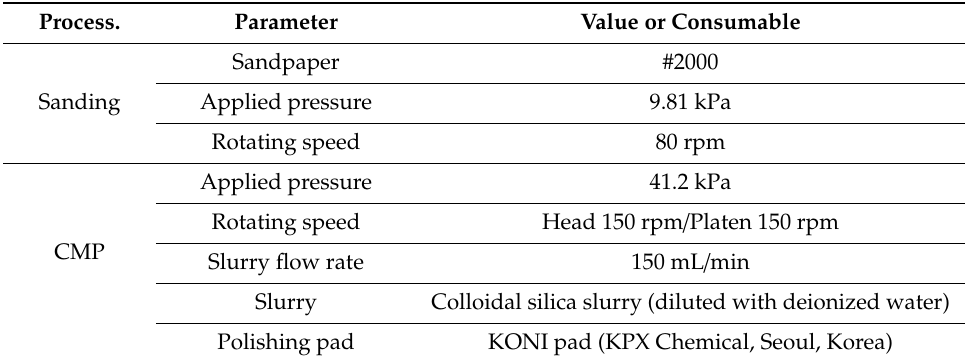
Table 2. Two cases of polishing methods.